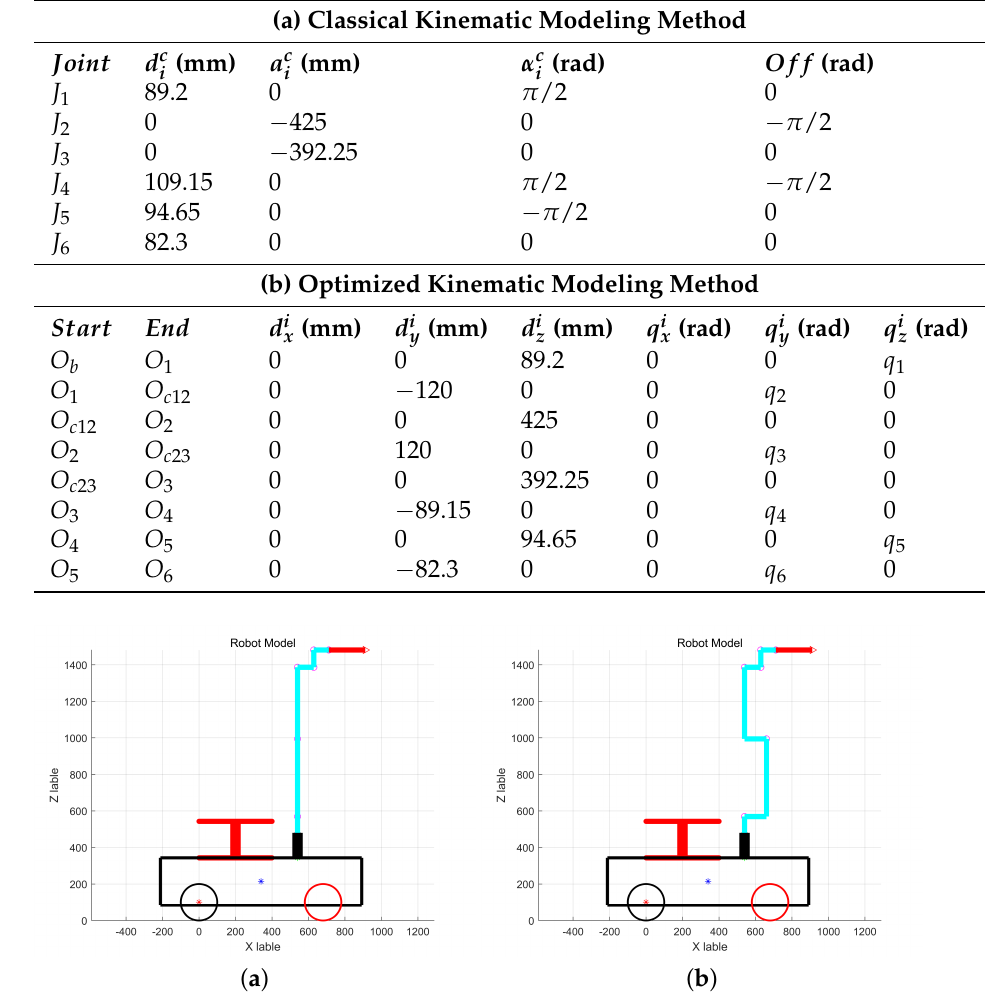
Table 1. The key parameters obtained for different kinematic modeling methods.